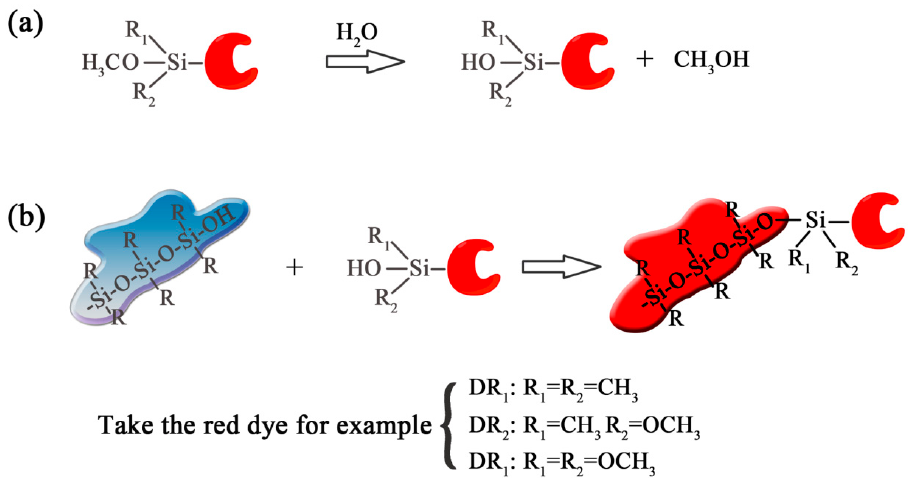
Figure 1. Illustration of coloring the silicone rubbers. ( a ) Formation of the dyes’ silanol; ( b ) Dyes’ silanol connected with the molecular of silicone rubbers through covalent bonds.